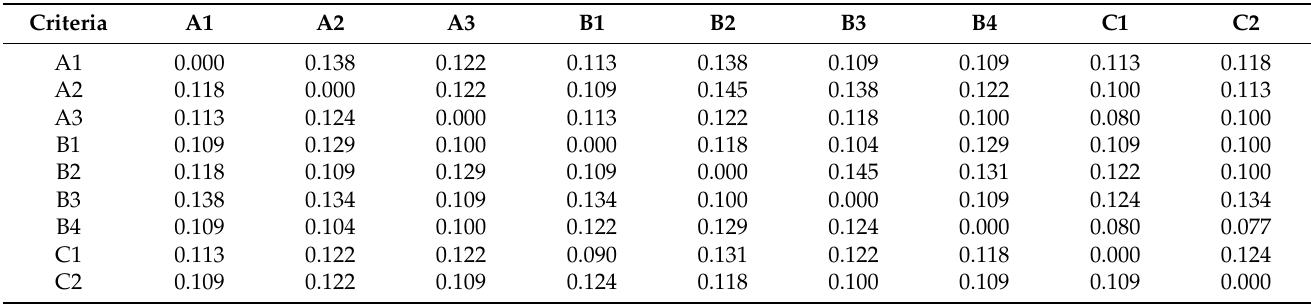
Table 2. Normalized Direct-Relation Matrix.